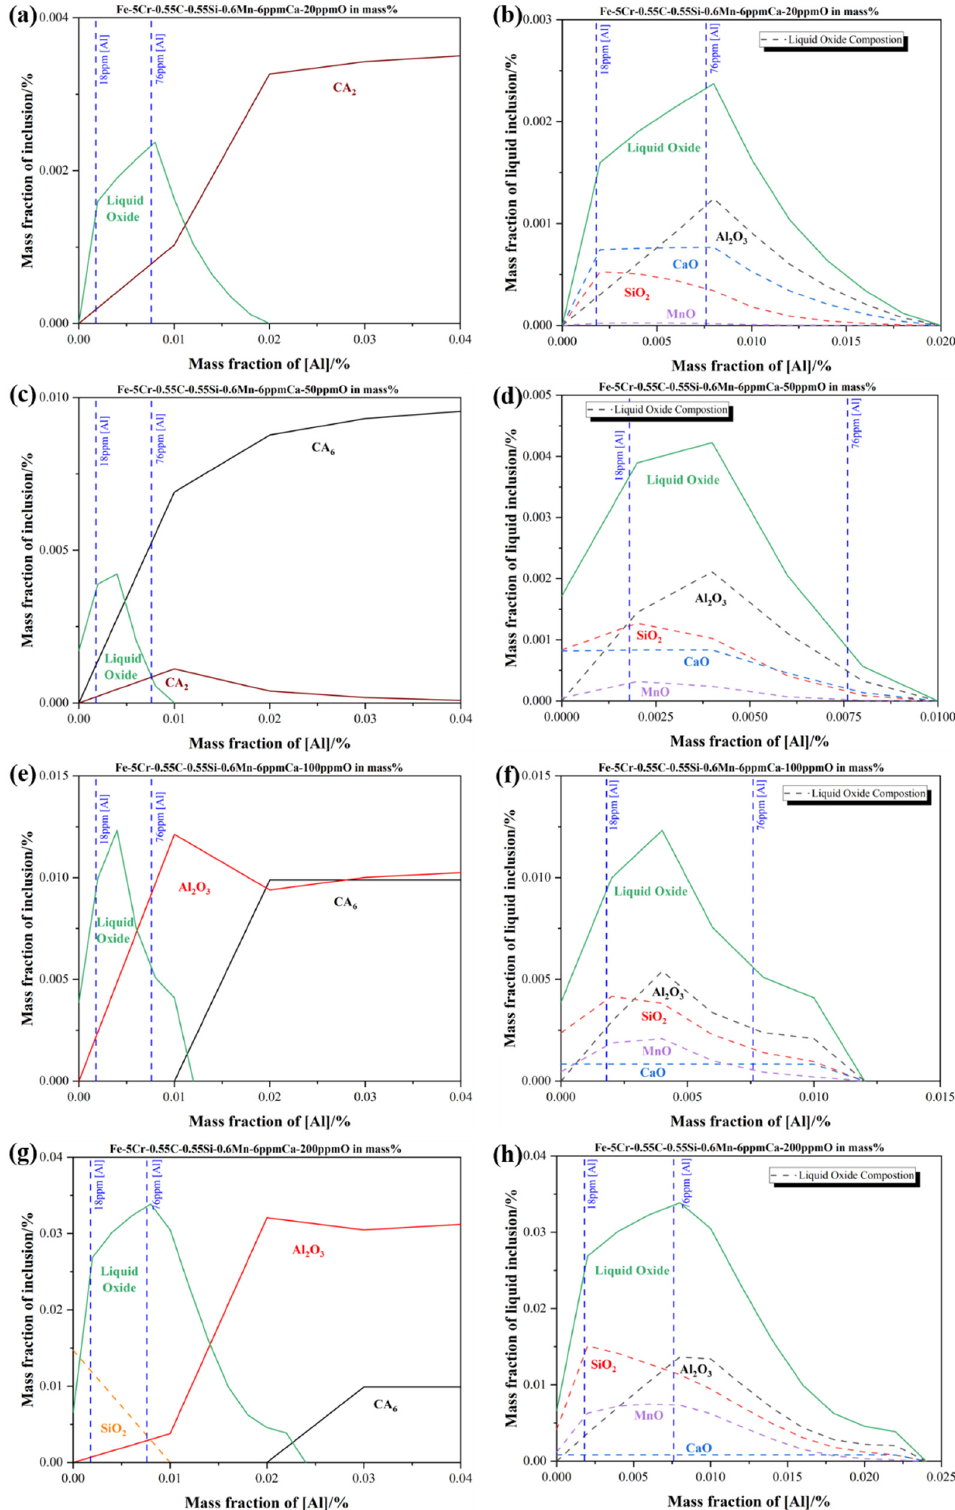
Figure 7. Equilibrium formation of inclusions during different soluble oxygen content stages at 1873 K in Fe-5Cr-0.55C-0.55Si-0.6Mn-6 ppm Ca-Al in mass % ( a , b ) with 20 ppm ( c , d ) with 50 ppm ( e , f ) with 100 ppm ( g , h ) with 200 ppm ( a , c , e , g ) present the formation of all inclusions at different oxygen content ( b , d , f , h ) present the actual composition of liquid oxide inclusions corresponding to the previous one, respectively.